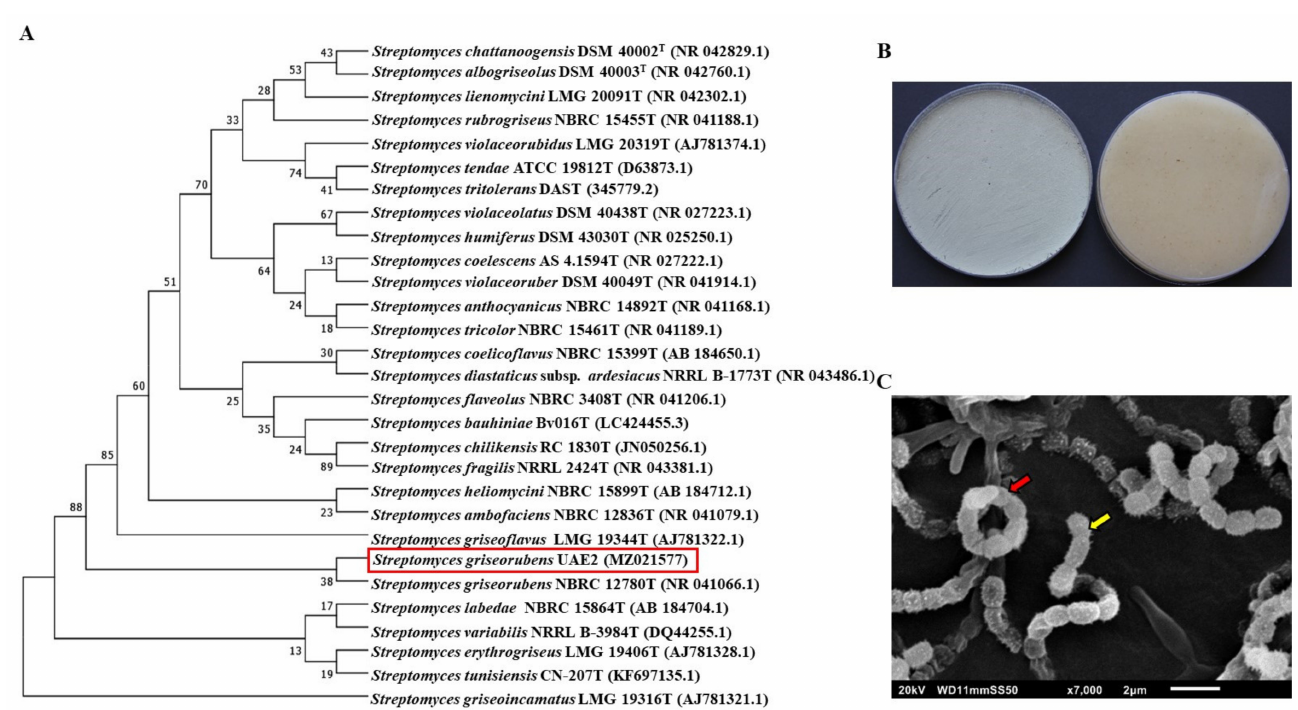
Figure 4. Phylogenetic, cultural and morphological characteristics of Streptomyces griseorubens UAE2 (BCA3, ACCD- producing isolate). ( A ) The phylogenetic tree showing the relationships between S. griseorubens UAE2 (isolate 21; MZ021577; 1518 bp) and other Streptomyces spp. according to 16S rRNA sequences. ( B ) Gray aerial (left) and colorless substrate (right) mycelia growing on ISP3 medium supplemented with yeast extract. ( C ) Scanning electron micrograph (7000 × ) of spiral spore chains (red arrow) and spiny-surfaced spores (yellow arrow) of S. griseorubens UAE2. In ( A ), numbers at nodes indicate percentage levels of bootstrap support based on a neighbor-joining analysis of 500 resampled datasets. GenBank accession numbers are given in parentheses. BCA, biological control